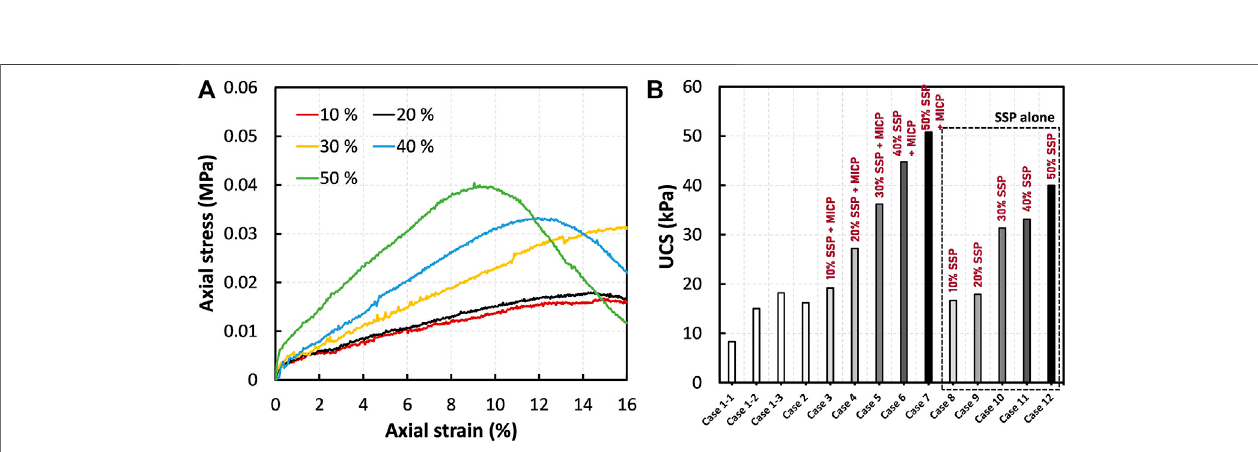
FIGURE 5 | (A) Effect of SSP on the stress-strain responses of peat (without MICP): comparison between the cases 8 – 12, and (B) comparison of UCS with both MICP and control cases.